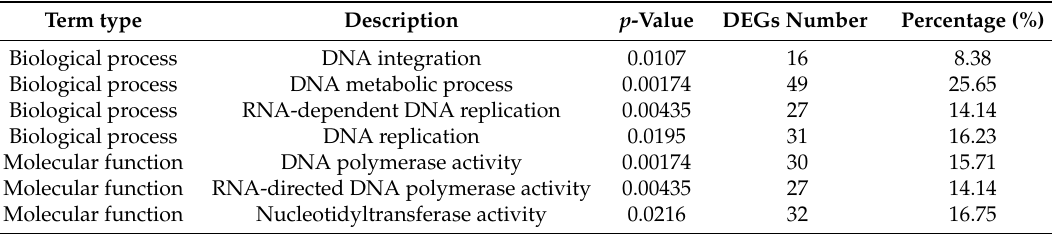
Table 3. Substantially enriched GO terms of DEGs.